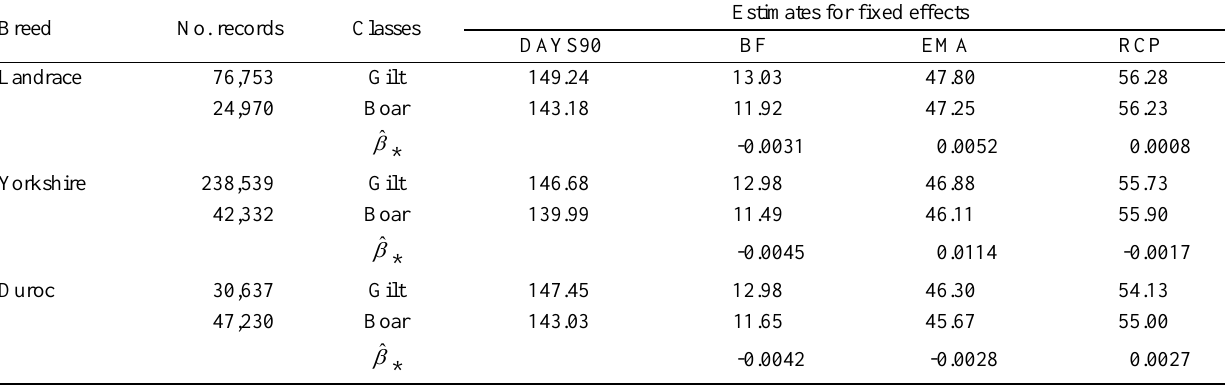
Table 2. Solutions and least squares means for the fixed effects from least squares models Breed No. records